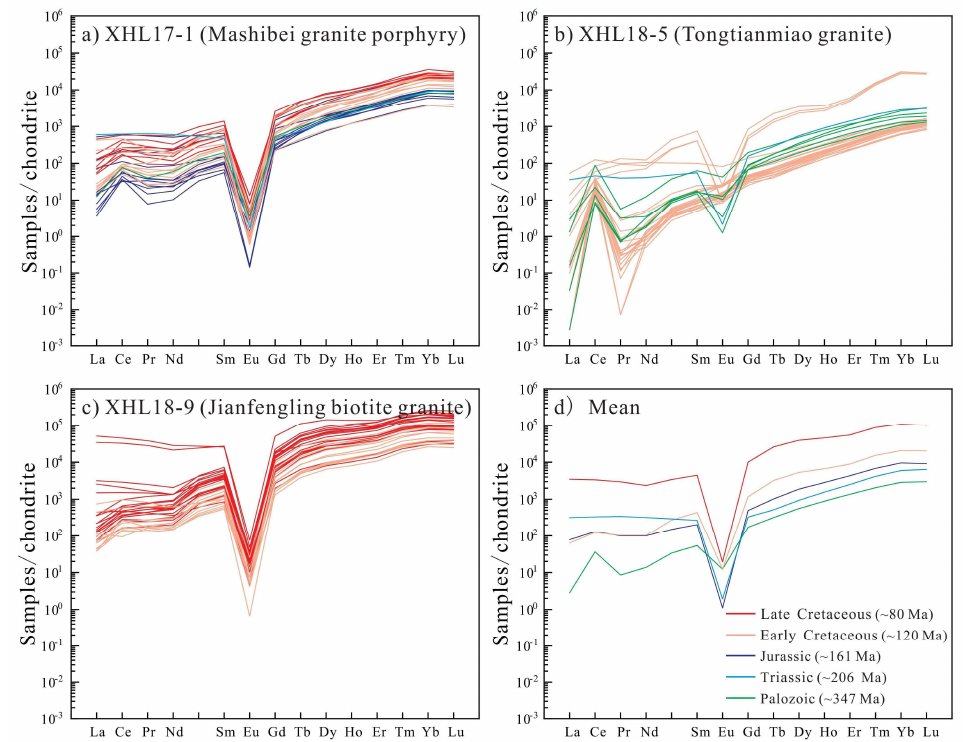
Figure 11. The chondrite-normalized REE patterns of granites from three plutons [39]. ( a ) sample XHL17-1; ( b ) sample XHL18-5; ( c ) sample XHL18-9; ( d ) average content of three samples.